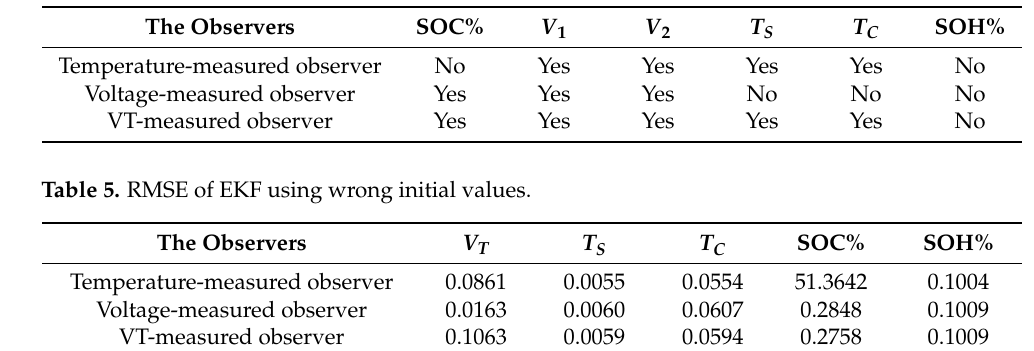
Figure 12. VT-measured observer estimation test using wrong parameters; ( a ) SOC, ( b ) service temperature changing, ( c ) SOH, ( d ) terminal voltage, ( e ) core temperature changing. Table 4. Observers’ observability for different states.